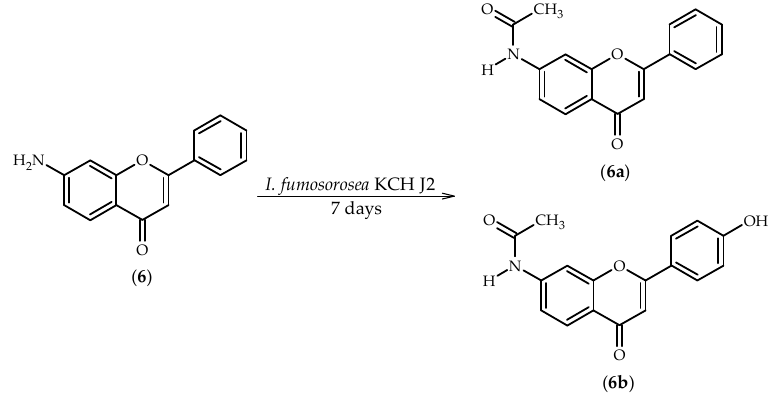
Scheme 6. Microbial transformation of 7-aminoflavone ( 6 ) in I. fumosorosea KCH J2 In the case of compound 6a ( 6b ), a broad singlet at δ = 9.78 ppm (δ = 9.73) in the 1 H-NMR corresponds to the -NH proton attached to C-7 and was not present in the spectrum of the substrate ( 6 ). For compound 6 , the signal of the two amino protons was observed at δ = 5.82 ppm in the 1 H- NMR spectrum. In the HMBC spectrum, a -CH 3 signal, absent in the case of the substrate (singlet at δ = 2.21 ppm on 1 H-NMR and δ = 24.5 ppm (δ = 24.5 ppm for 6b ) on 13 C-NMR) correlated with the signal at δ = 169.9 ppm (δ = 169.8 ppm for 6b ) from the carbonyl carbon of the acetamide group. Carbonyl carbon from the acetamide group correlated with the signal at δ = 7.46 ppm that came from towards lower field values, suggesting the appearance of a deactivating substituent in their vicinity.